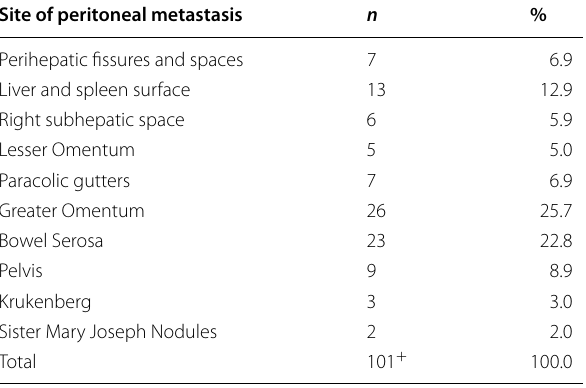
+ Most of the included patients showed more than one site of peritoneal metastasis